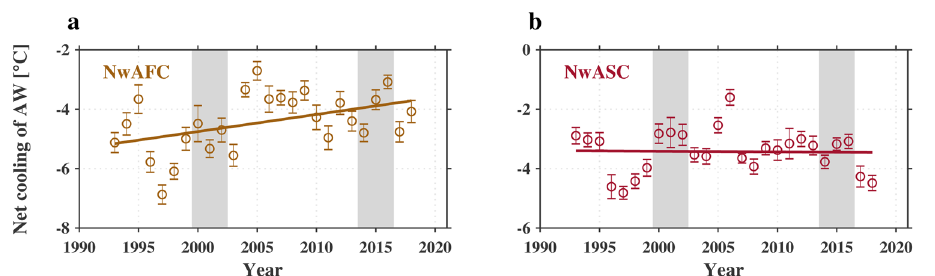
Fig. 4 | Long-term evolution in the net cooling of Atlantic Water. a Norwegian Atlantic Front Current (NwAFC) and b Norwegian Atlantic Slope Current (NwASC), for the layer 0 – 200m. The solid line shows the linear fi t used to obtain the long- termtrend.Theerrorbarsindicatethestandarderror(seeSupplementaryFig.4for